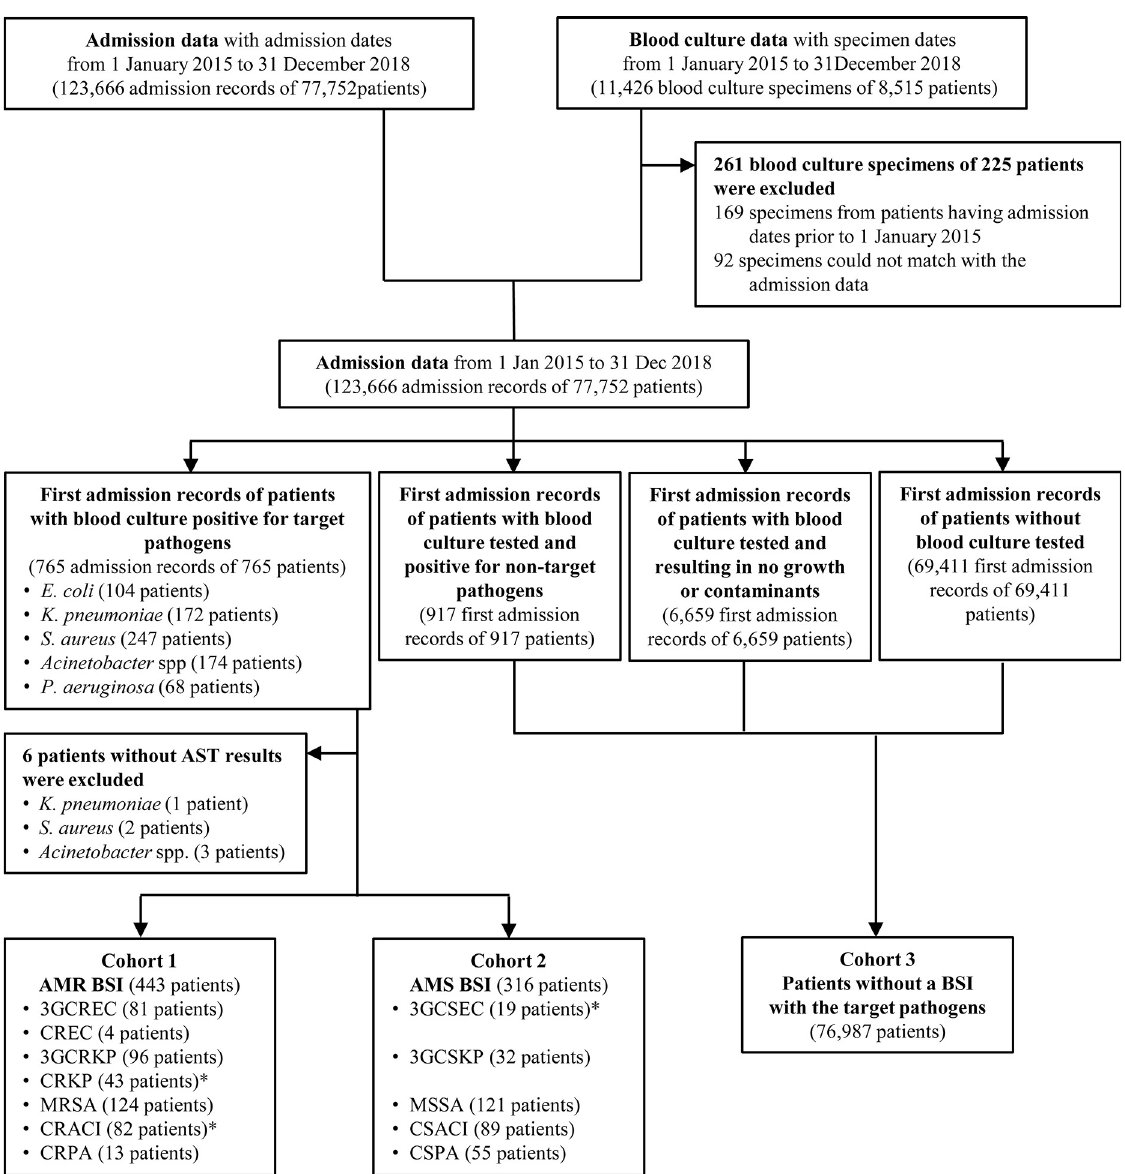
Fig 1. Flow diagram. For cohort 1 and cohort 2, only the first admission with BSI caused by the target pathogens was included in the analyses. For cohort 3, only the first admission was included in the analyses. Target pathogens included E . coli (EC), K . pneumoniae (KP), S . aureus (SA), Acinetobacter spp. (ACI) and P . aeruginosa (PA); 3GCREC = 3rd generation cephalosporin resistant and carbapenem- susceptible E . coli ; CREC = 3rd generation cephalosporin resistant and carbapenem-resistant E . coli ; MRSA = methicillin-resistant S . aureus ; CRACI = carbapenem-resistant Acinetobacter spp.; 3GCSEC = 3rd generation cephalosporin-susceptible E . coli ; CSACI = carbapenem- susceptible Acinetobacter spp.